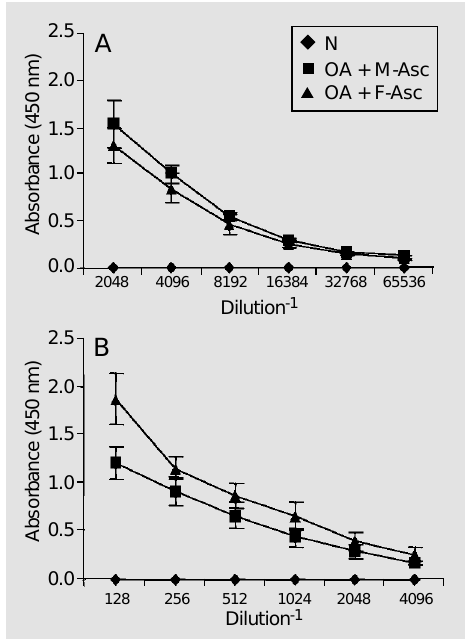
Inguinal and periaortic lymph node cells from mice immunized 9 days before with OA + F-Asc, M-Asc or E-Asc in complete Freund’s adjuvant were stimulated with 500 µg/ ml F-Asc or M-Asc or 250 µg protein/ml E-Asc. IL-2 was quantified in supernatants harvested after 24 h and IFN- g and IL-4 in supernatants obtained after 72 h. The results represent the mean ± SD of duplicate cultures. Non-stimulated cells produced <0.19 ng/ml of IL-2, <1.56 ng/ml of IFN- g and <31.2 pg/ml of IL-4. For abbreviations, see legends to Tables 1 and 2.